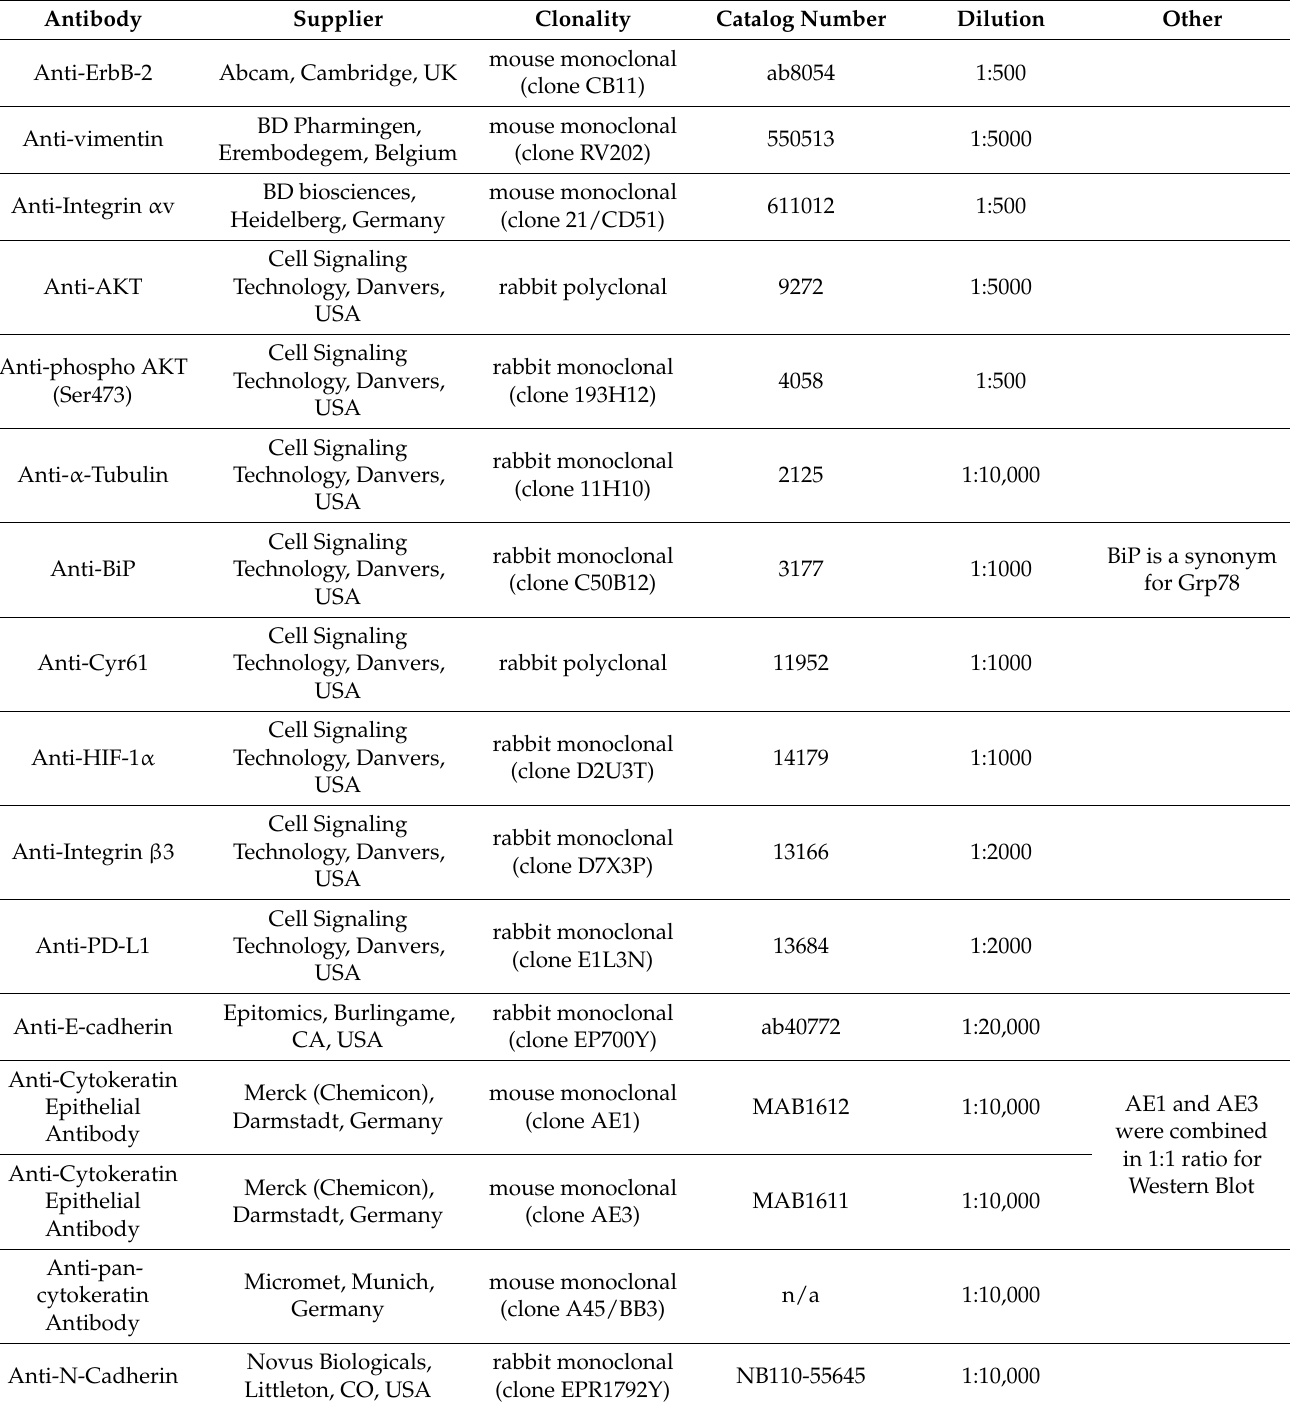
Table 2. Antibodies and conditions used for the Western blot